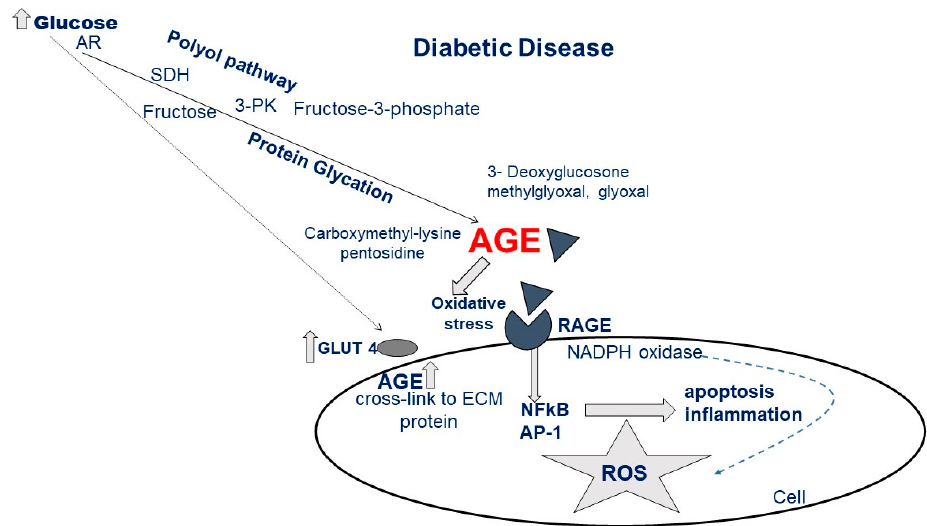
Figure 1. Metabolic pathways leading to advanced glycation end products (AGE) generation and cellular effects after interaction of AGE with the receptor for AGE (RAGE) (AR, aldose reductase; SDH, sorbitol dehydrogenase; 3-PK, 3-phosphokinase; for other acronyms see the list of Abbreviations).